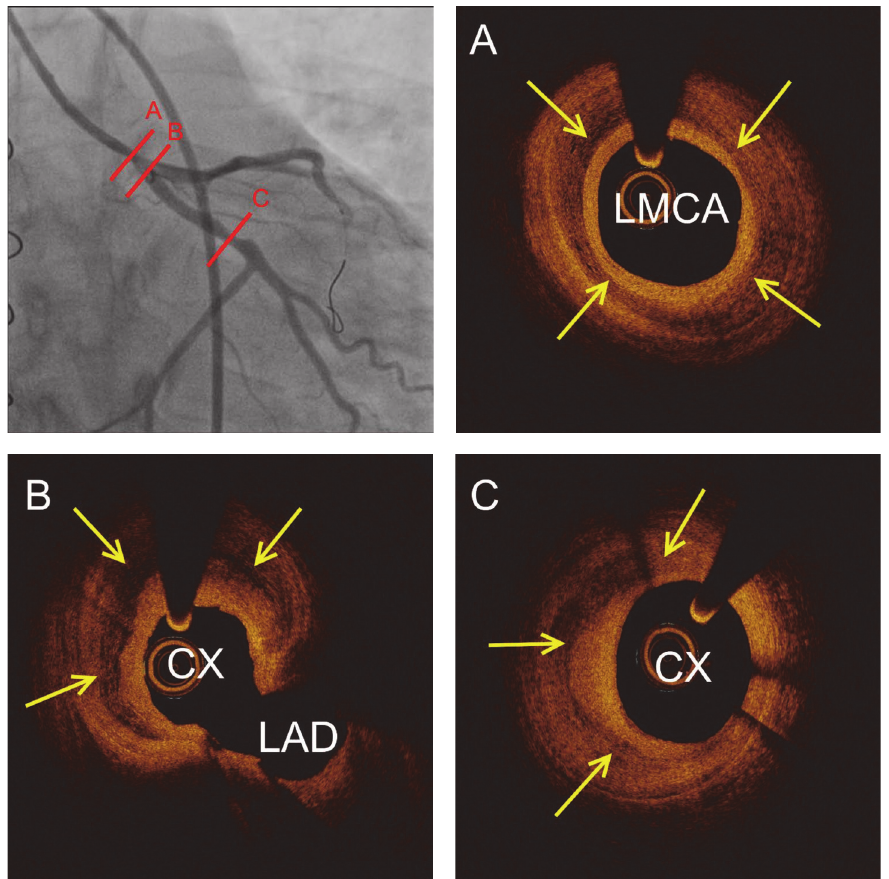
Figure 3: Intravascular optical coherence tomography at the angiographic lesion sites. (A) Circumflex layered massive organized thrombus in the left main coronary artery (LMCA) covering the ostium of the circumflex (CX) and left anterior descending coronary artery (LAD) (B). Furthermore, crescent-shaped layered organized thrombus was seen in the distal part of the circumflex (C). Yellow arrows show layered thrombosis within the intima vessel